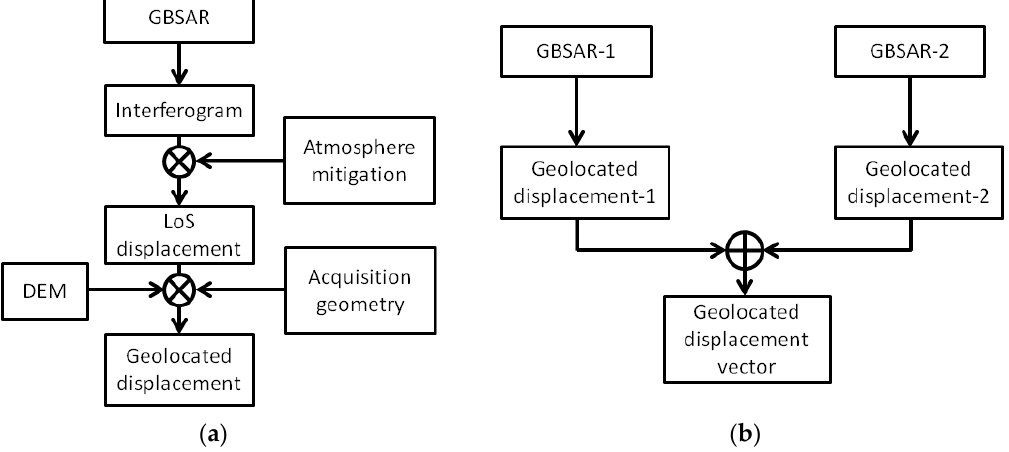
Figure 3. LoS factor spatial distribution over the dam mesh.